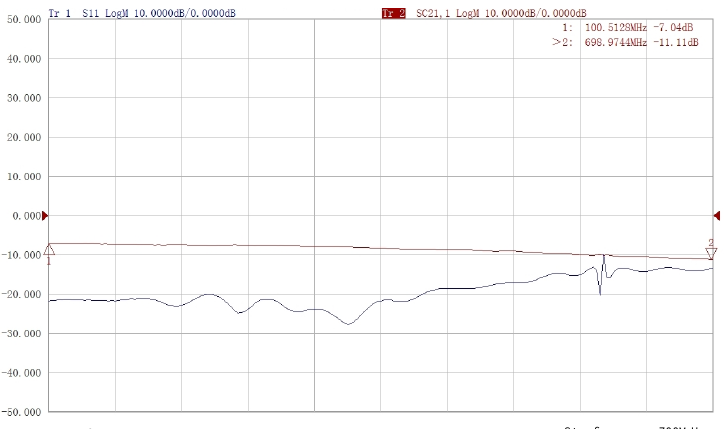
Figure 12. Up-conversion loss of mixer